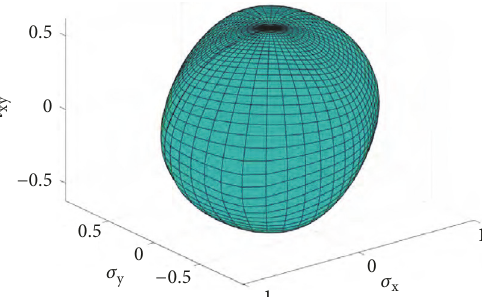
Figure 7: Barlat’s Yld2004-18p function under plane stress hypoth- esis.